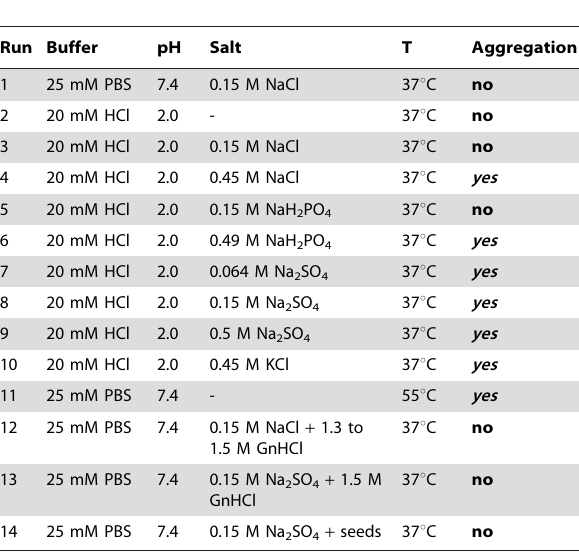
Table 1. Summary of all investigated conditions. Protein concentration is 1 g/L in all